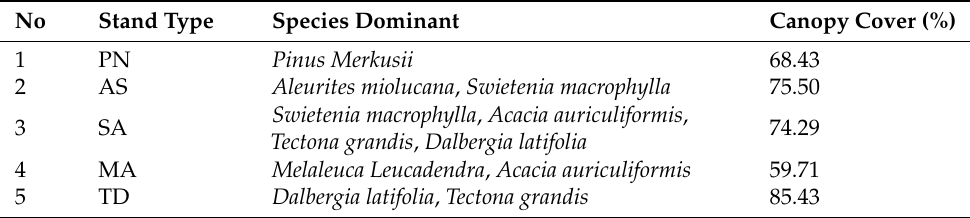
Table 1. Stand types in the protected forest of Kulon Progo Community